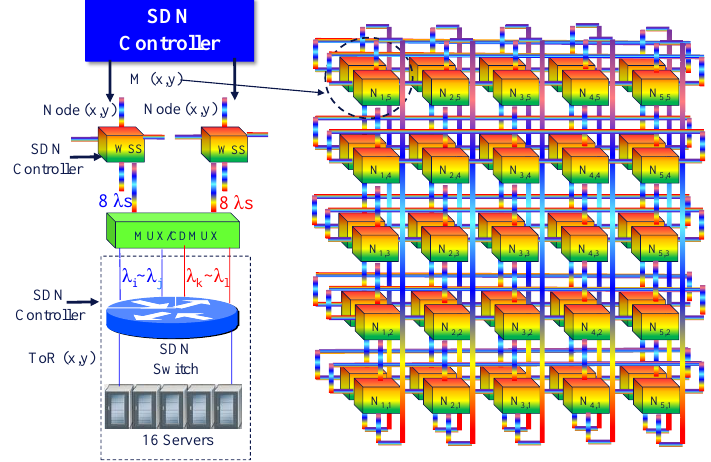
Figure 4. Two-plane Torus topology optical tunnel switching network with 25 nodes.